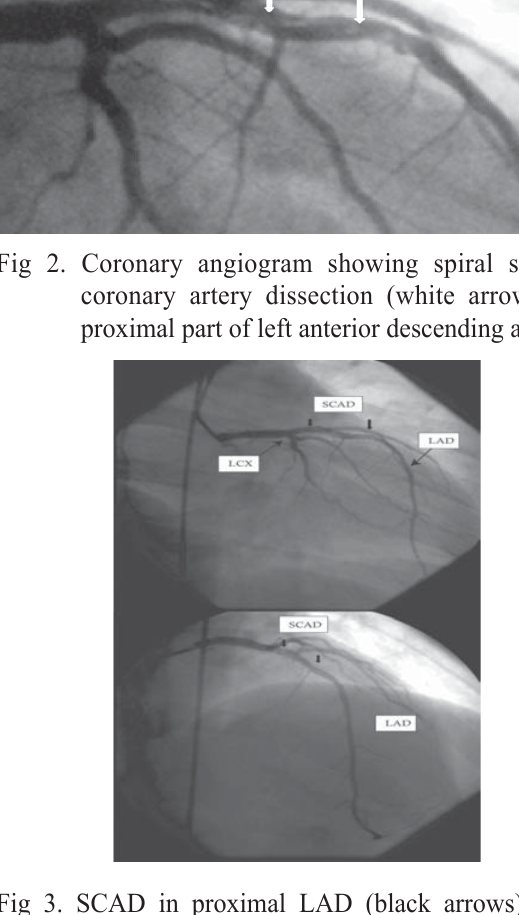
Fig 3. SCAD in proximal LAD (black arrows) with distal TIMI III